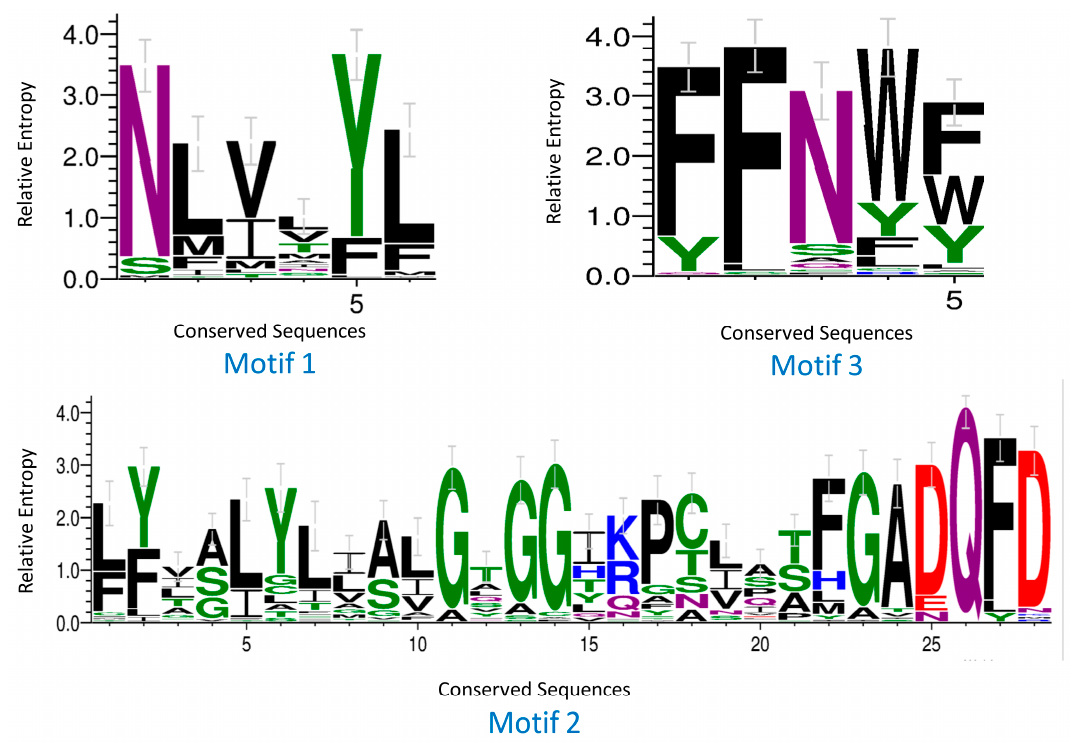
Figure 3. Sequence analysis of conserved domains from apple NPF proteins. X -axis, sequence of conserved motif; Y -axis, relative entropy that reflects rate of conservation for each amino acid.